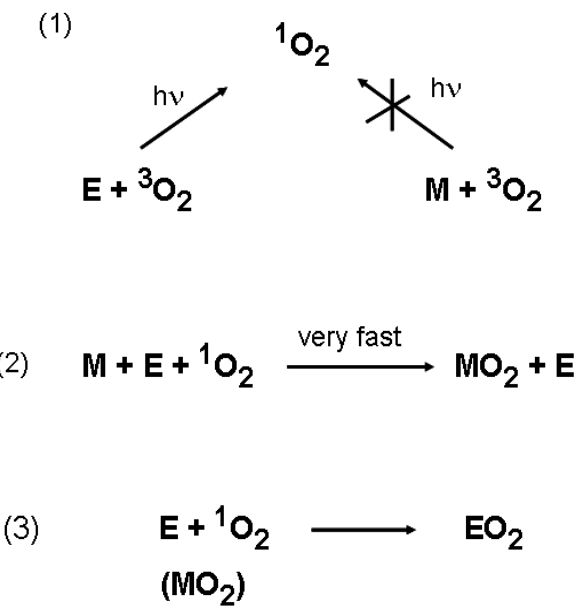
Figure 3. (1) A solution of M and E in equal amounts is irradiated under dioxygen bubbling; E produces singlet oxygen (the food) in contrast to M, which is unable to do so. (2) M swallows and con- sumes all the food available. (3) M being entirely transformed into MO 2 , E can in turn eat the food and generate EO 2